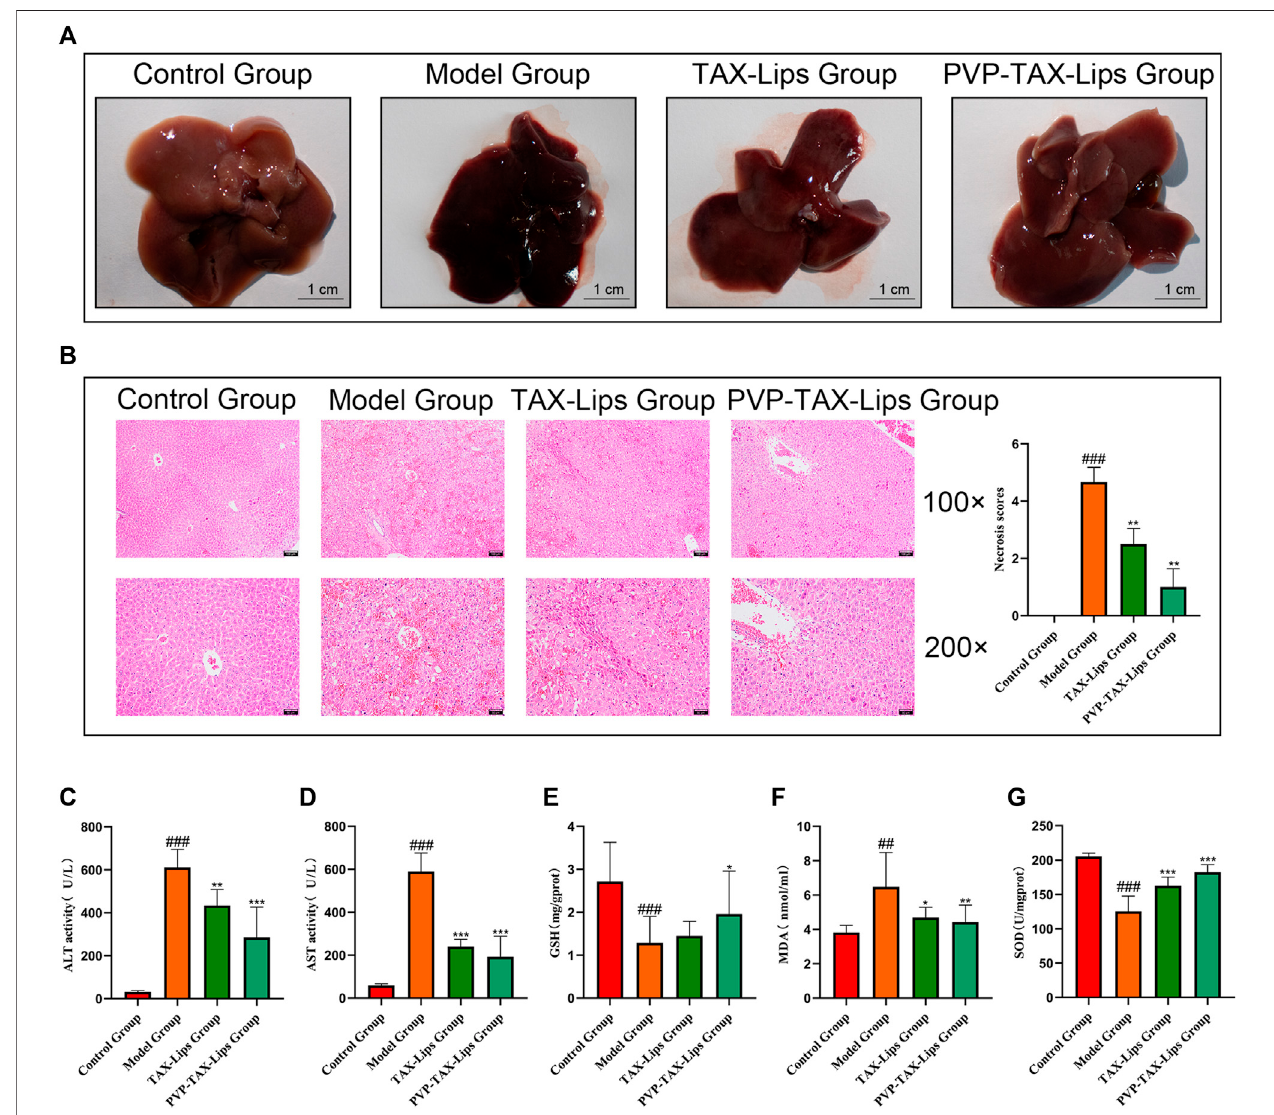
FIGURE 4 | Acute liver injury in mice. (A) Effects of TAX-Lips and PVP-TAX-Lips on the appearance of the liver in mice. (B) H&E-stained liver tissue sections, with magni fi cationsof×100and200X,andthenecrosisscoreoftheliver. (C,D) ALTandASTlevelsinmiceserum. (E – G) GSH,MDA,andSODcontentinthemicelivertissue. As compared with the control group, ## p < 0.01,### p < 0.001; As compared with the model group, * p < 0.05, ** p < 0.01, *** p < 0.001. The data are presented as the mean ± SD (n = 8).